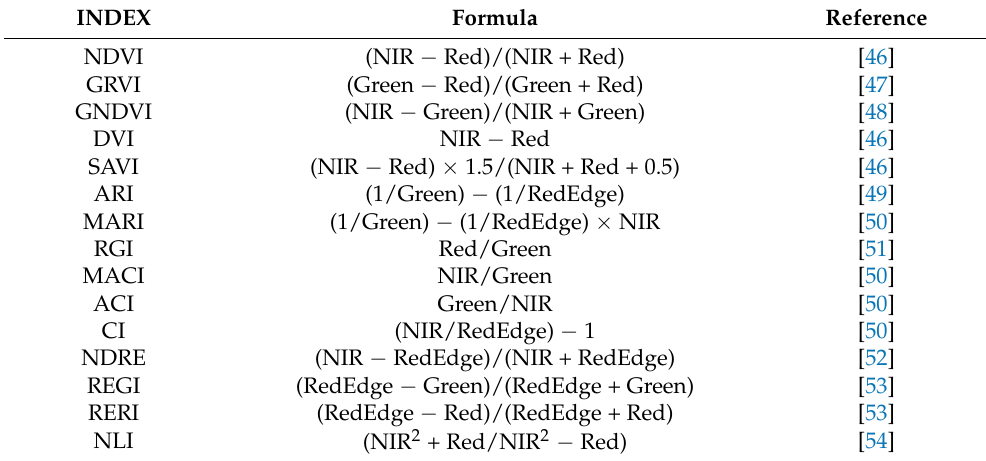
Table 2. Indices and formula for